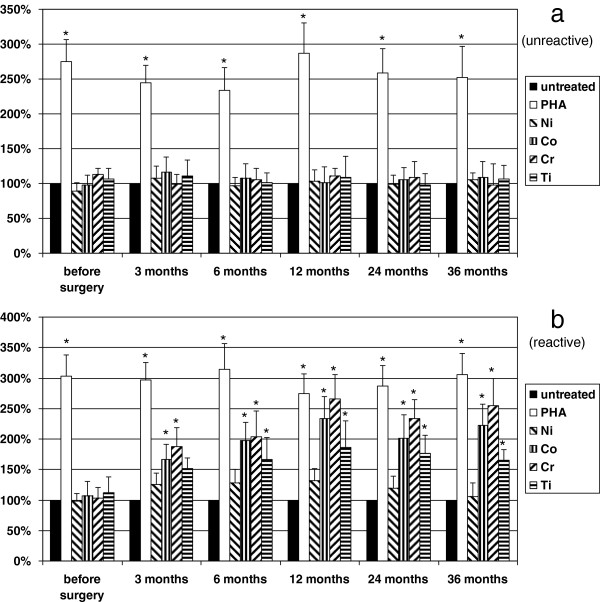
The effect of various metals and PHA on IFN-γ production of patients’ leukocytes. The effect of various metals (Ti 0.01 mM, Co 0.1 mM, Cr 0.1 mM, Ni 0.1 mM) and PHA (0.1 mg/ml) on IFN-γ production of patients’ leukocytes in group 3 is shown. Cells were untreated or treated as indicated. (a) (unreactive) it is clearly demonstrated that metal challenge did not influence significantly the cytokine release before and after the surgery. (b) (reactive) however, Co, Cr, and Ti increased the IFN-γ secretion significantly 3 months after surgery in 21% (8 patients) of group 3, which was increased up to 30% (12 patients) after 36 months, distinguishing a subgroup referred here as metal-sensitive patients in group 3. Positive control PHA increased IFN-γ production significantly in each experiment. Columns represent means + SD, level of significance is shown, *p < 0.05. Note that Ni did not influence IFN-γ secretion significantly.